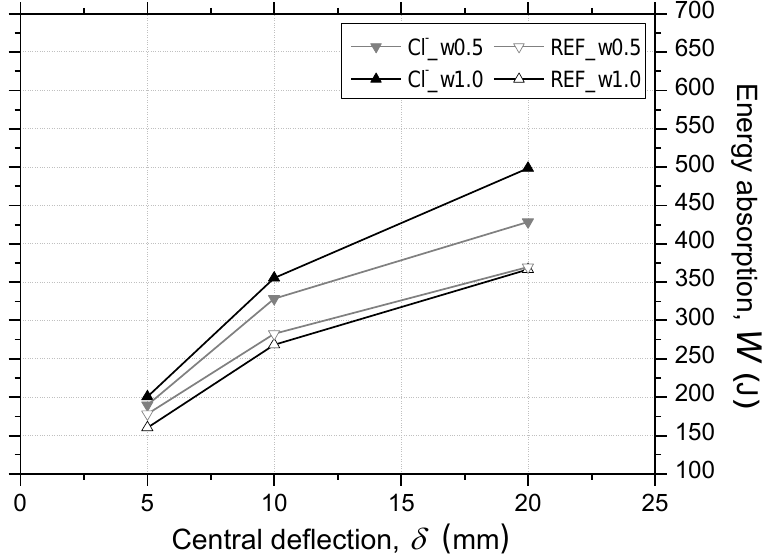
Figure 10. Average energy absorption–central deflection ( W − δ ) relationships for pre-cracked panels from RPT-3ps after the exposure period of 90 days.